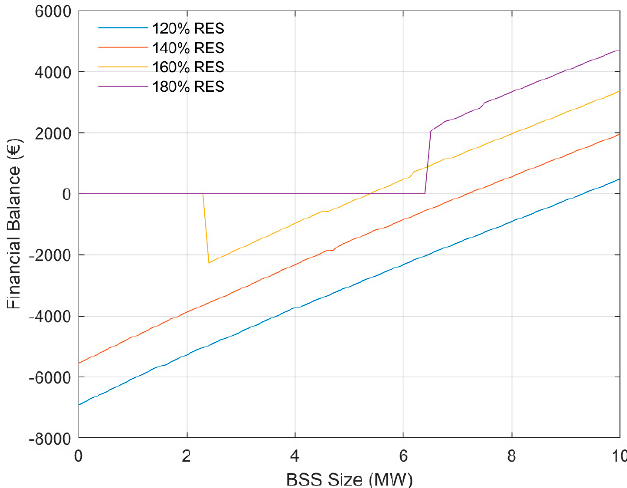
Figure 3. MGO’s financial balance as a function of BSS size for di ff erent RES sizes under the non-critical locations case.